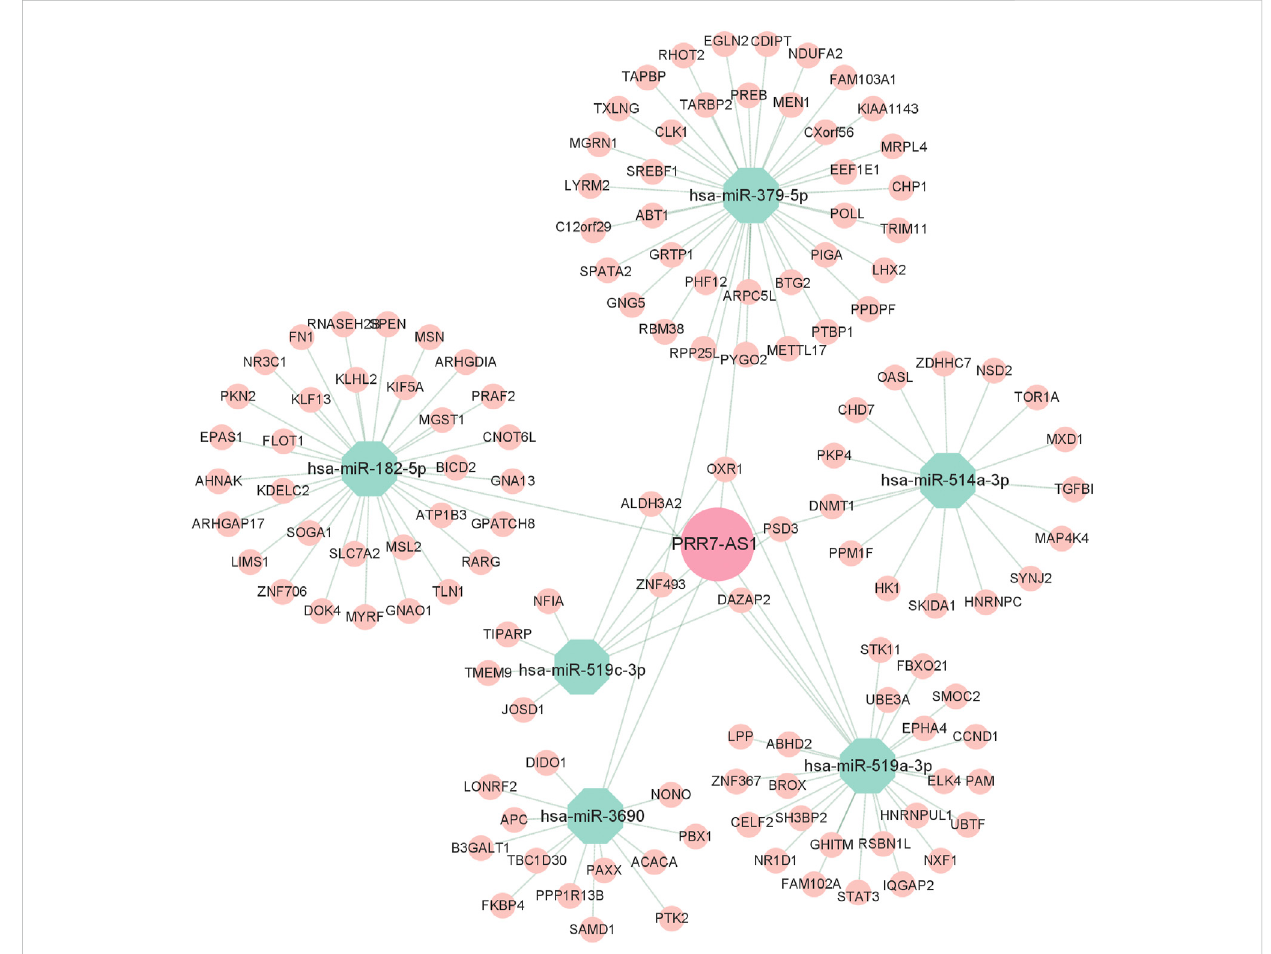
CeRNA regulatory networks for PRR7-AS1. Diamond represent lncRNA, Octagons represent miRNA, Circles represent